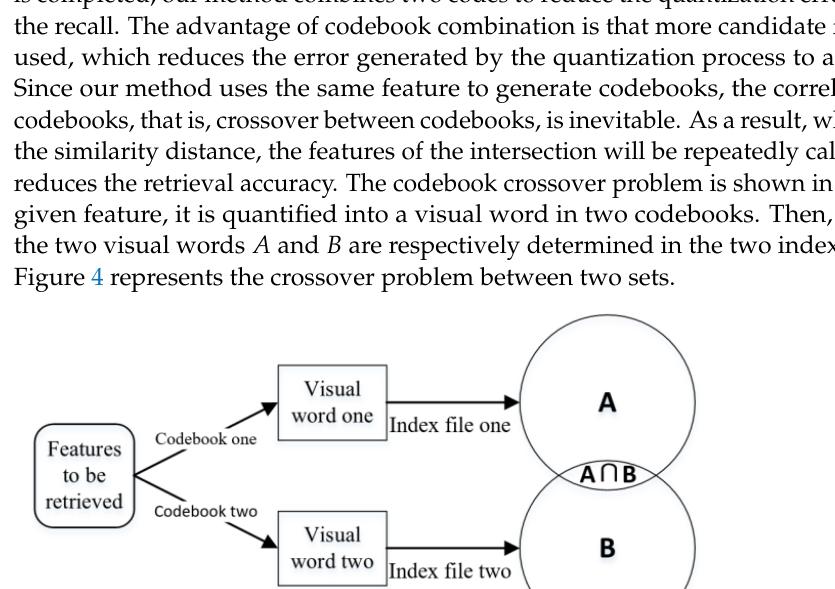
Figure 3. The DSP-SIFT feature extraction process.